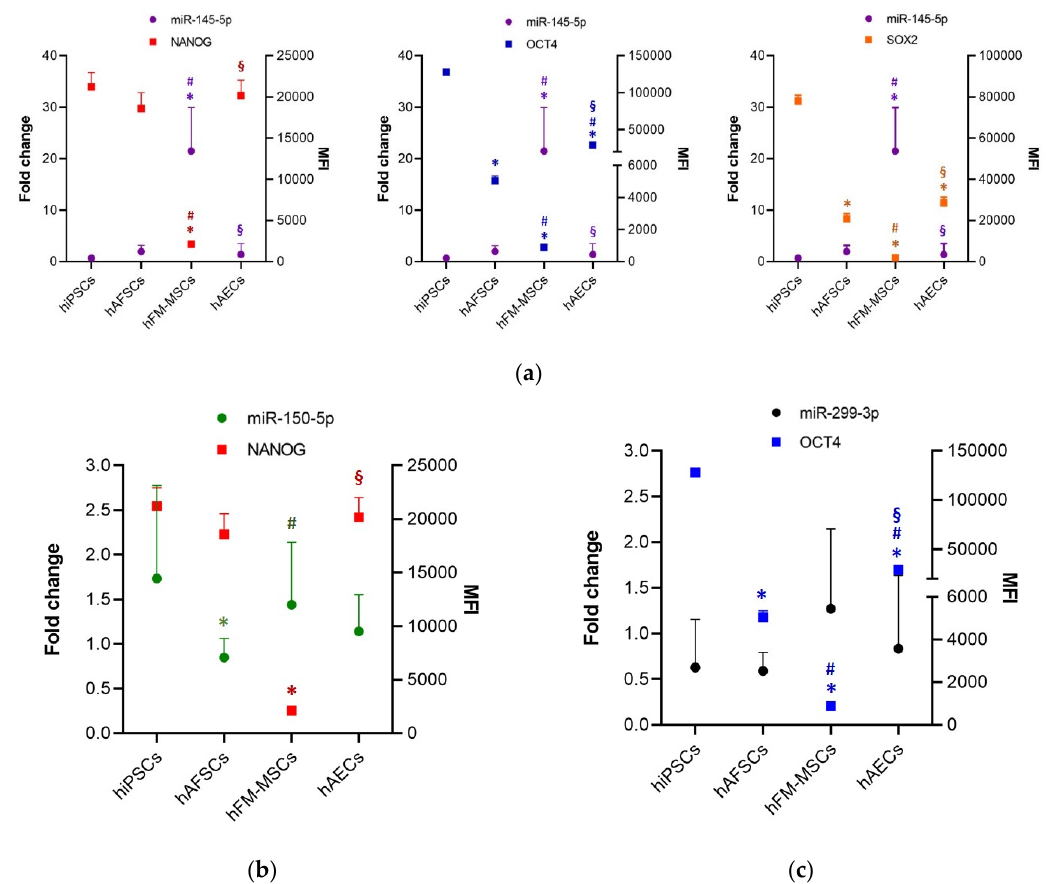
Figure 5. The detection of miR-299-3p, miR-150-5p, and miR-145-5p in hiPSCs and perinatal SCs and their relationship with the protein expression of NANOG, OCT4, and SOX2. The graph shows the ( a ) miR-145-5p expression, ( b ) miR-150-5p, and ( c ) miR-299-3p (primary y axis) and the expression of the NANOG, OCT4, and SOX2 proteins, as measured with the mean fluorescence intensity by the immunocytometry analysis (secondary y axis) in SCs from different fetal annexes. The miRNAs were detected by real time PCR, the fold change was determined from the −ΔΔ Ct values, calculated using U6 as reference gene and normalized to hiPSCs, as the control condition. The graphs show the mean ± SD of 5 independent experiments, p < 0.05 with hiPSCs (*), hAFSCs (#), and hFM ‐ MSCs (§).